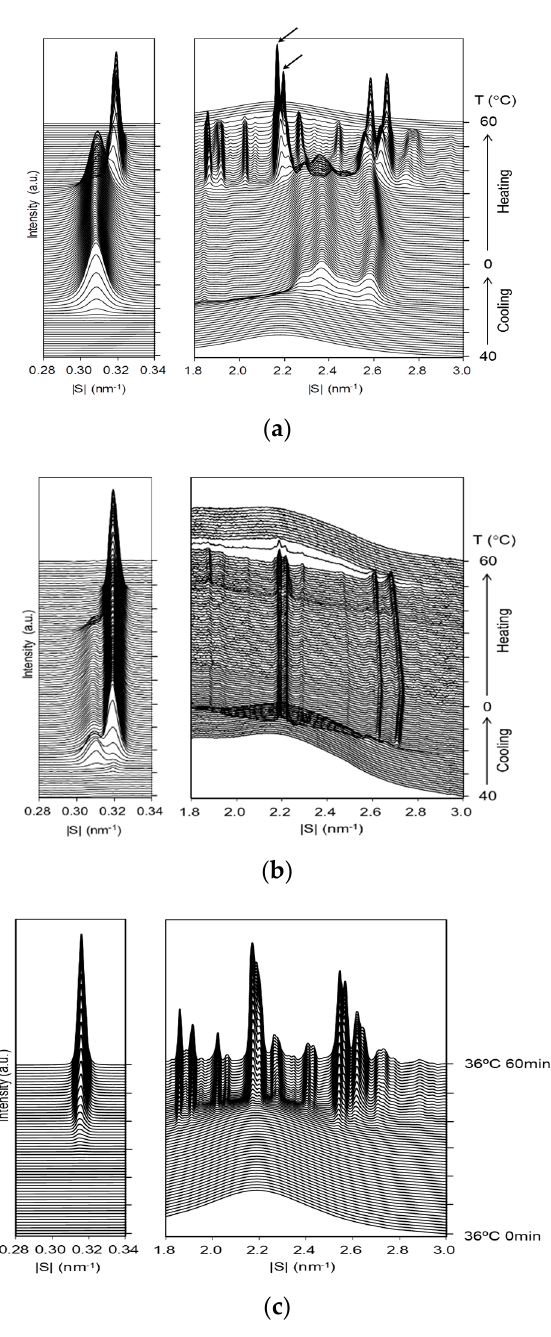
Figure 2. Time-dependent changes of synchrotron X-ray diffraction (SR-XRD) profiles in small-angle X-ray scattering (SAXS) and wide-angle X-ray scattering (WAXS) regions. ( a ) Crystallization of neat LLL with a constant cooling rate of 1 °C/min, ( b ) crystallization of LLL/HOPG with the same cooling rate, and ( c ) isothermal crystallization at 36 °C of LLL/HOPG.